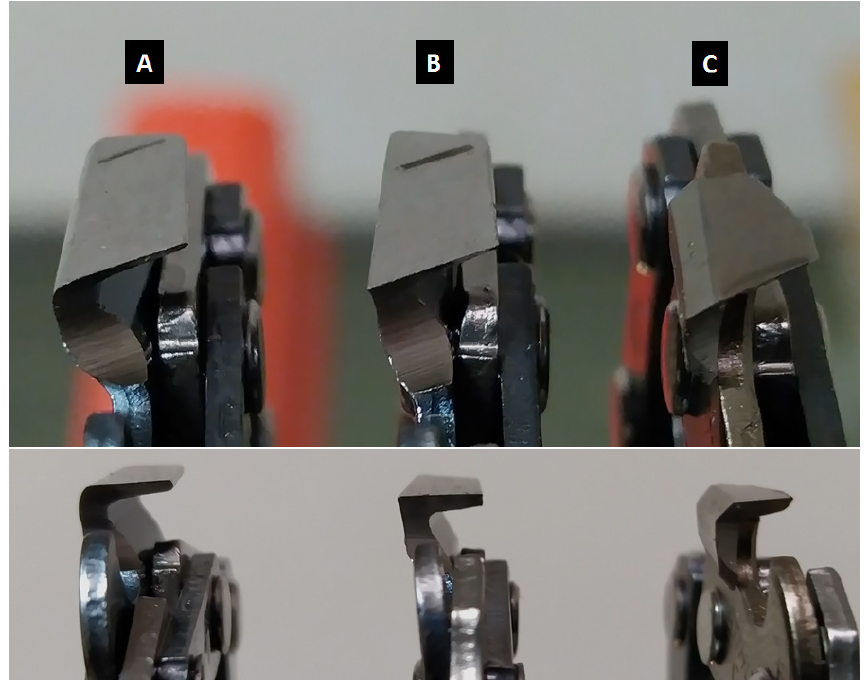
Figure 2. The different shapes of saw chain cutters used in the experiments: A—semi chisel, B—full chisel, C—chamfer chisel. chisel, C—chamfer